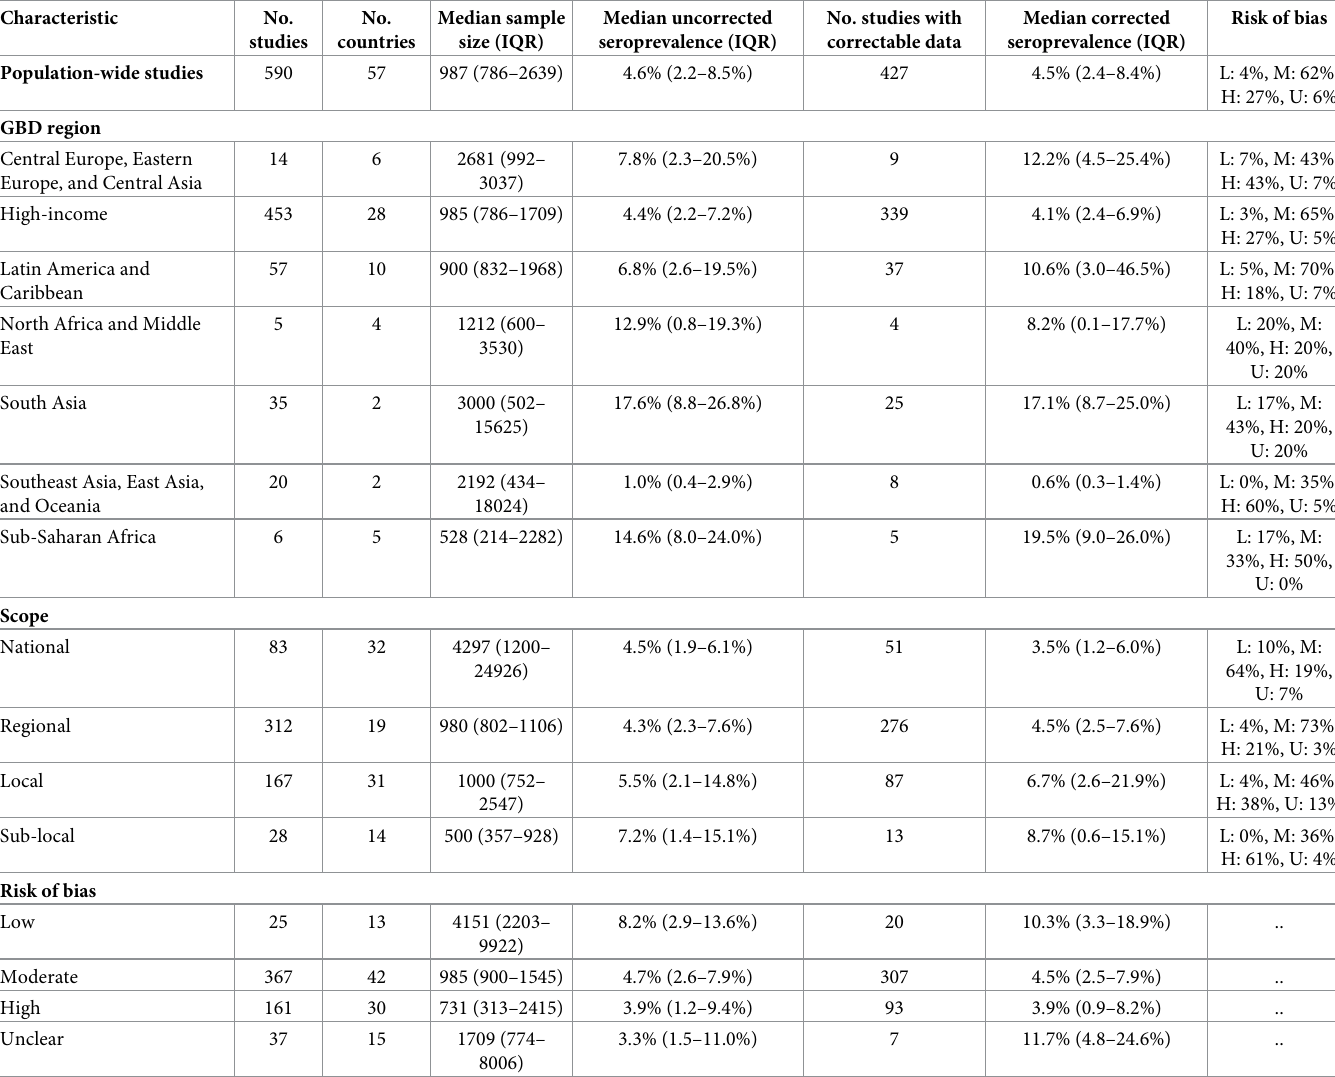
Table 2. Summary of seroprevalence data from studies reporting population-wide estimates by global burden of disease region, geographic scope, and risk of bias. Characteristic No.